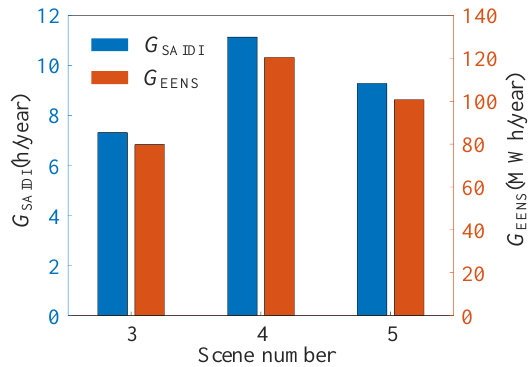
Figure 15. Reliability indices under different attack objects.